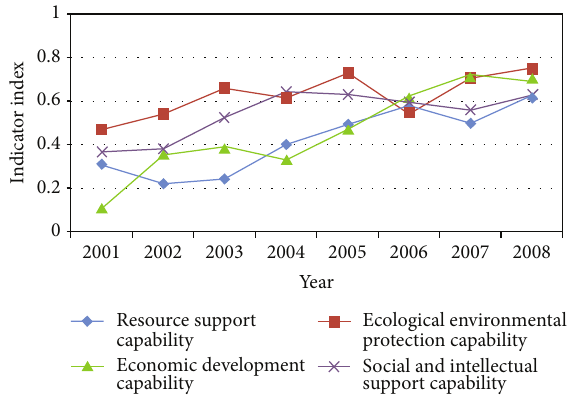
Figure 5: The comprehensive capability index of sustainable devel- opment